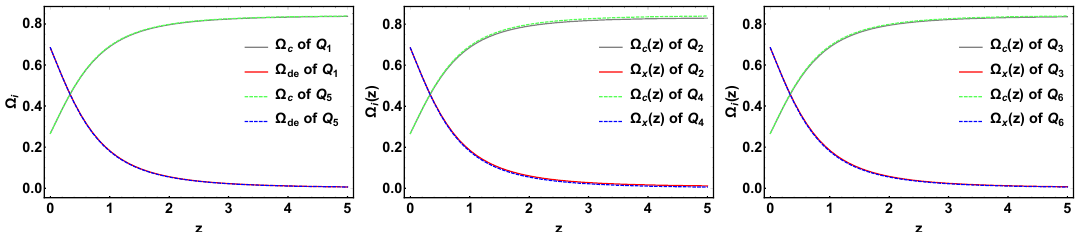
Figure 1. The evolution trajectories of Ω i versus red shift z of interacting dark energy models, to compare Q 1 and Q 5 , Q 2 and Q 4 , Q 3 and Q 6 , here we fixed w = − 1.1 and ξ = 0.02, the other related parameters was fixed as the results of Planck 2015, Ω de 0 = 0.684, Ω c 0 = 0.267, Ω b 0 = 0.049, Ω = r 0